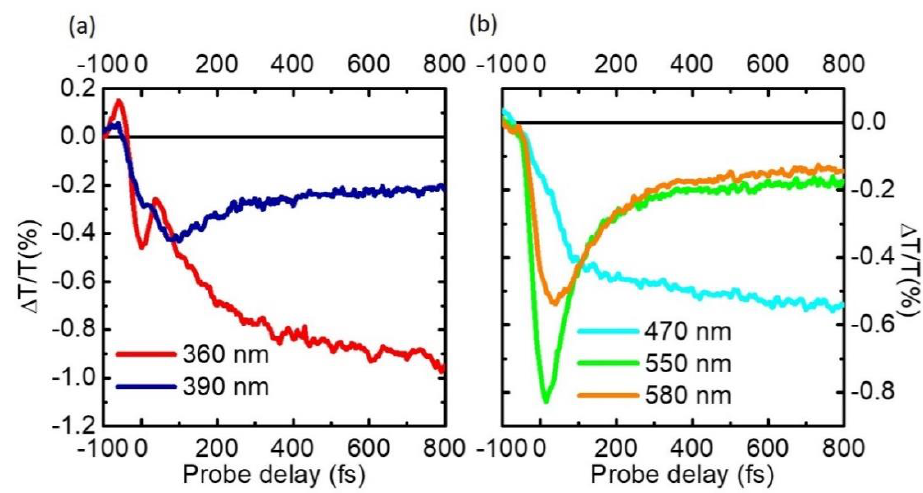
Figure 10. TA dynamics of pyrene following excitation at 270 nm, at UV ( a ) and visible ( b ) probe wavelengths.